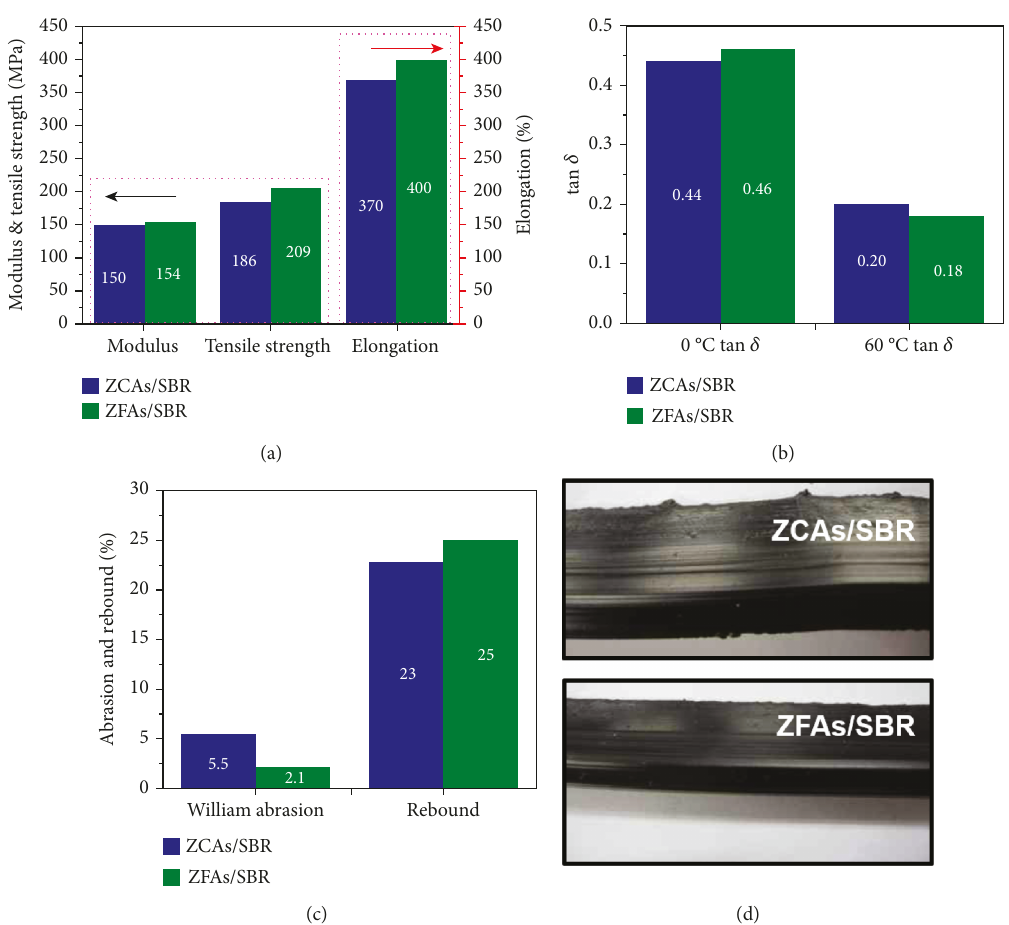
Figure 6: (a) Modulus, tensile strength, and elongation, (b) dynamic properties ( tan δ ), (c) abrasion and rebound, and (d) Garvey die extrusion images of tire tread compounds made with ZCA/styrene butadiene rubber (SBR) or ZFA/SBR